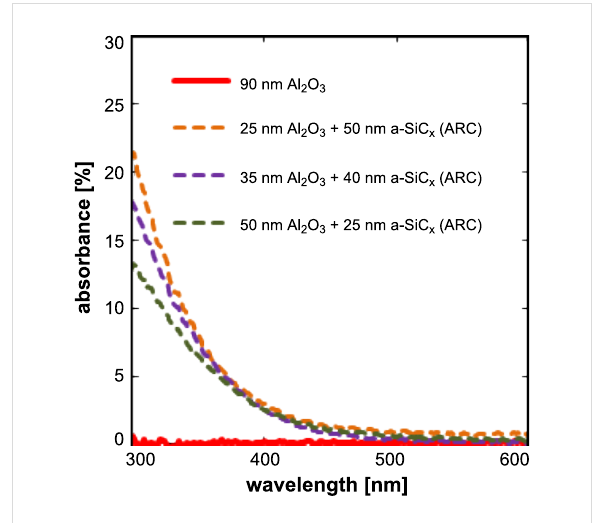
Figure 2: Absorbance as a function of the wavelength in the range from 300 to 600 nm. Dashed lines belong to stacks with different Al 2 O 3 thicknesses while the continuous red line is the absorbance of 90 nm Al 2 O 3